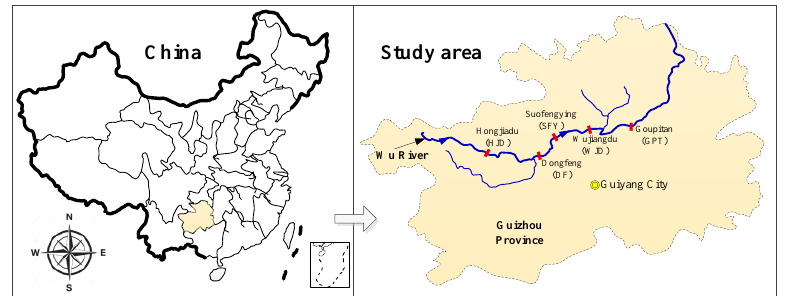
Figure 5. The topological structure of the studied hydropower reservoirs.